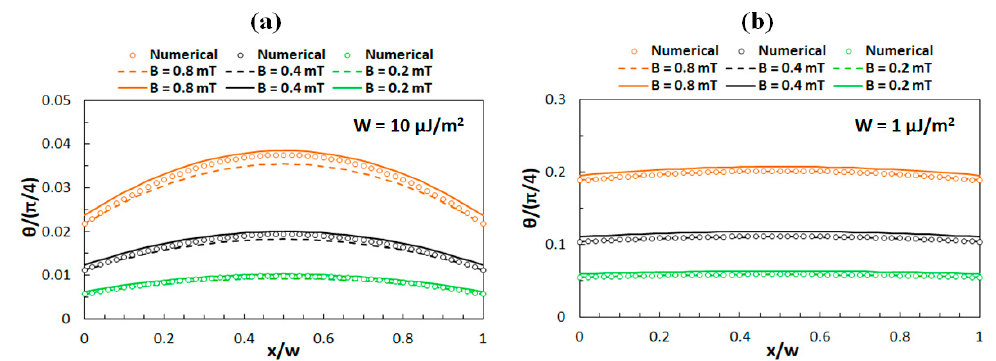
Figure 3. Numerical and analytical results for θ ( x ) for low external magnetic fields in case of ( a ) strong anchoring ( W = 10 μ J/m 2 ) and ( b ) weak anchoring ( W = 1 μ J/m 2 ). Circles correspond to the numerical solution, solid lines to Equation (9), and dashed lines to Equation (13). The results are given for three different field magnitudes.